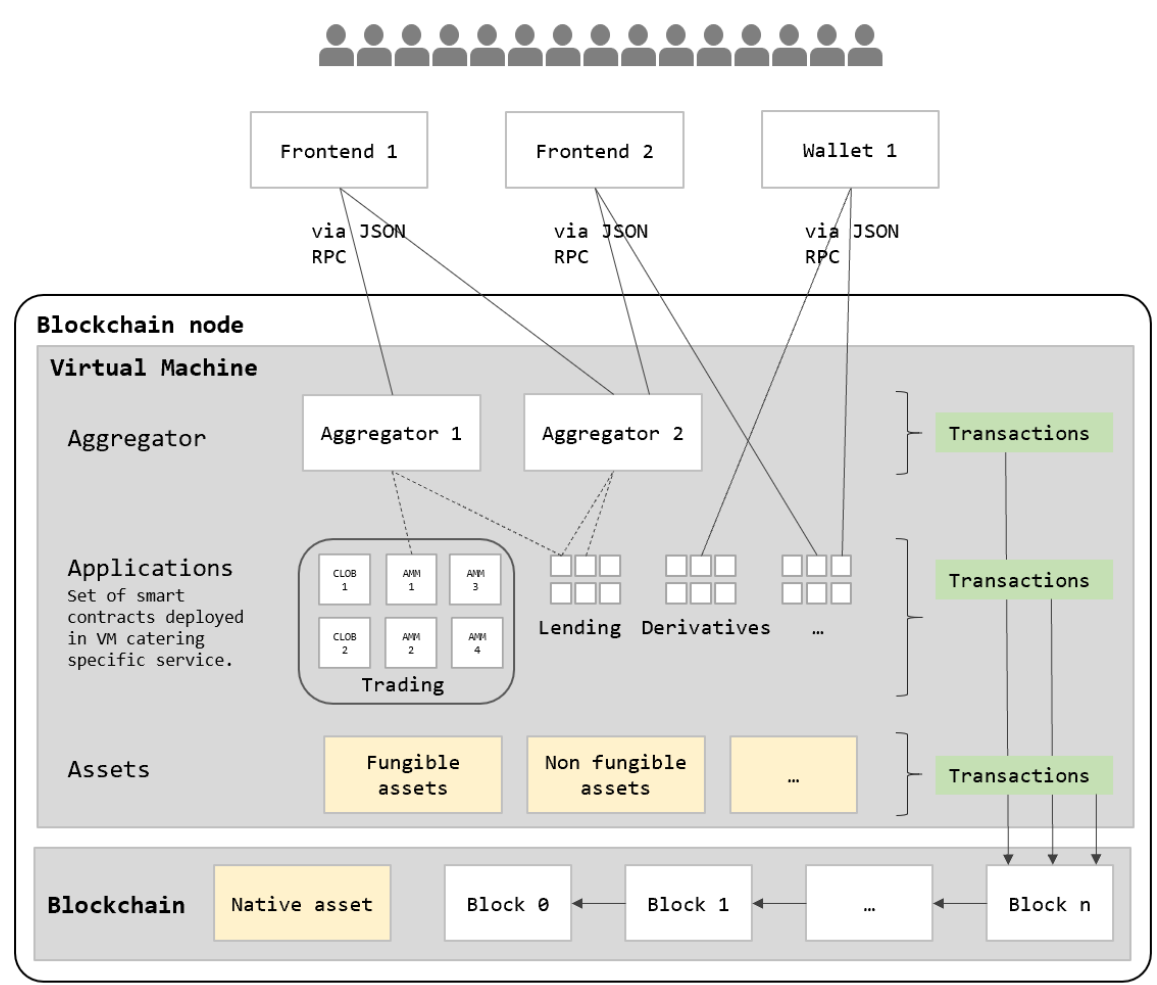
Figure 1. DeFi applications on permisionless